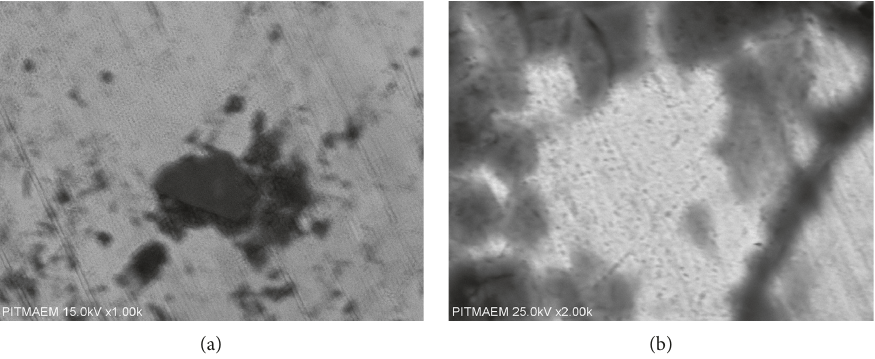
Figure 13: SEM images of brilliant green-treated PR leaves.